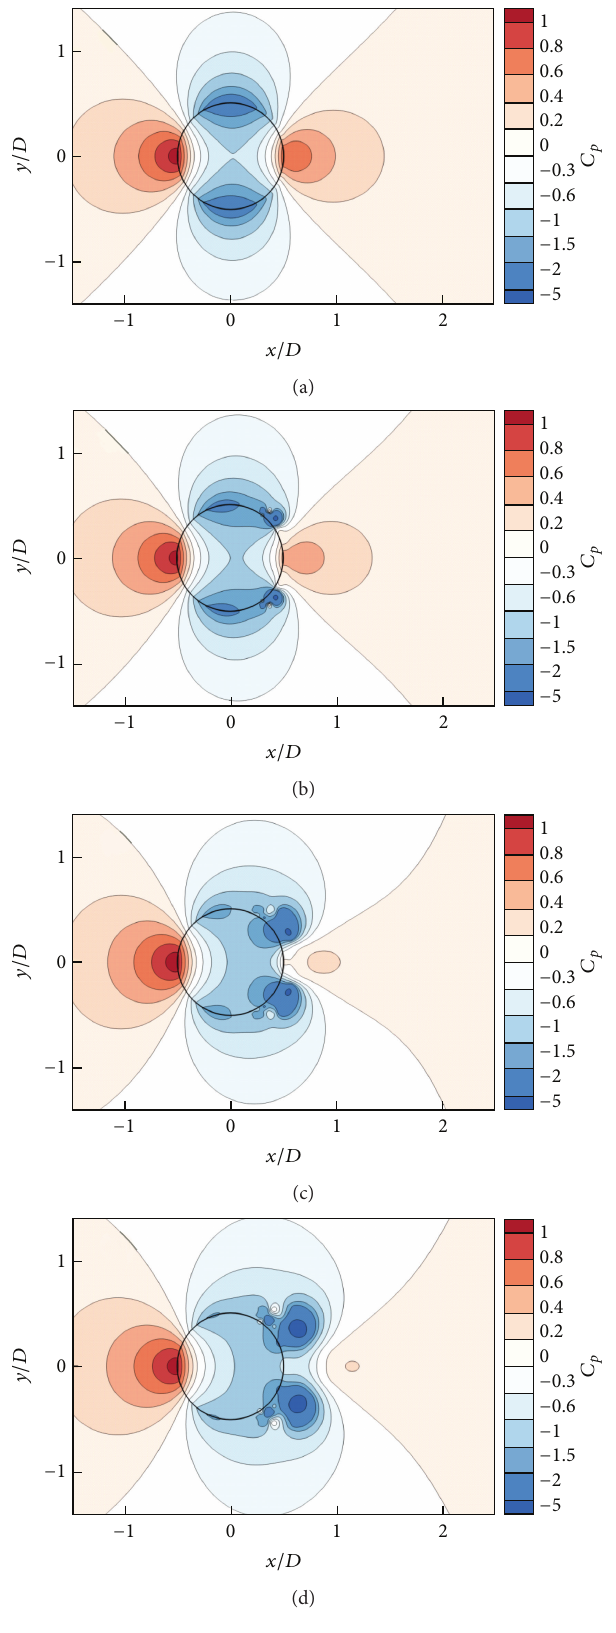
Figure 12: Pressure coefficient distribution around a circular cylin- der for Re = 9500 : (a) 𝑇 = 1 , (b) 𝑇 = 2 , (c) 𝑇 = 3 , and (d) 𝑇 = 4 .